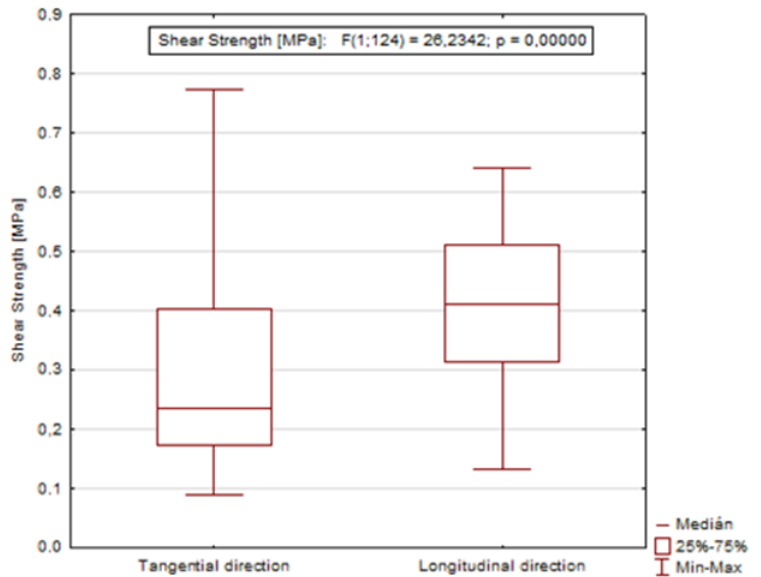
Figure 5. Comparison values of shear strength during dormant and growing season in longitudinal direction with similar wood species.